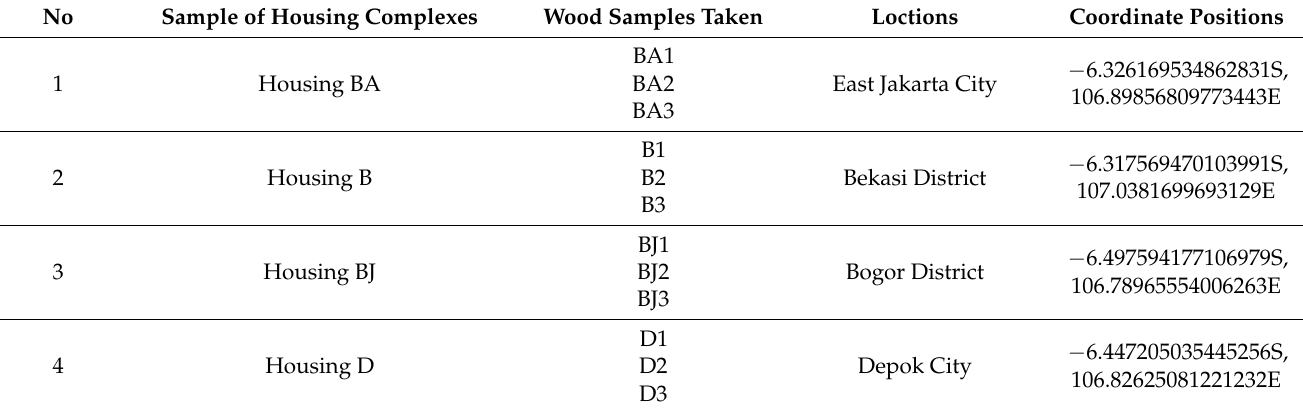
Table 1. List of the housing complexes that served as the research sites. Wood Samples